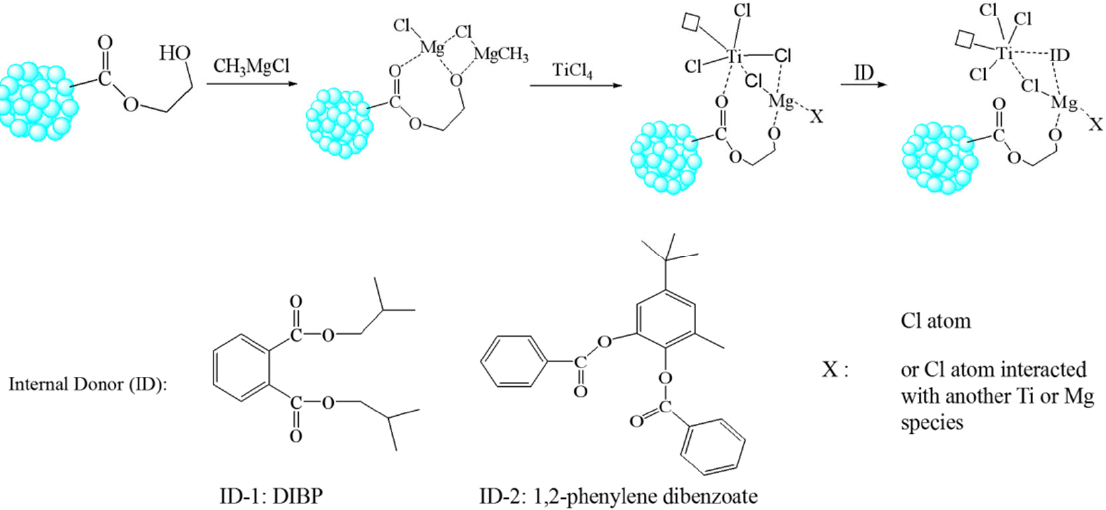
Figure 4. Plausible interaction mechanism of Mg/Ti active sites for the prepared POP ‐ based Ziegler– Natta catalyst.